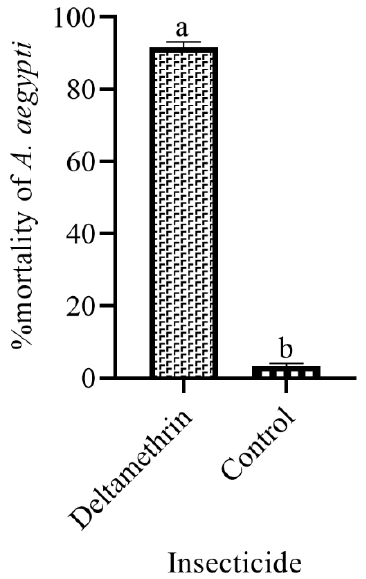
Figure 5. % mortality of females Ae. aegypti to different insecticides. These letter shows significant difference among treatments.